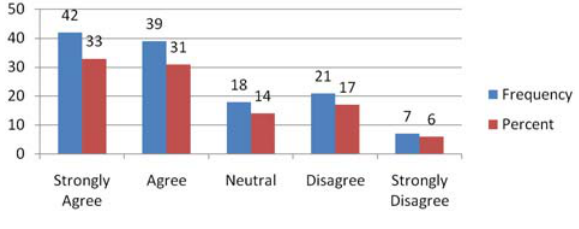
Fig. 10. Support from local